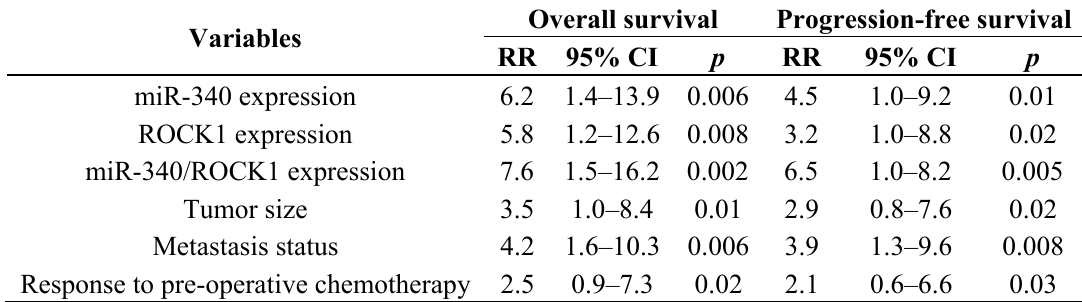
Table 2. Multivariate survival analysis of overall survival and progression-free survival in 92 patients with pediatric